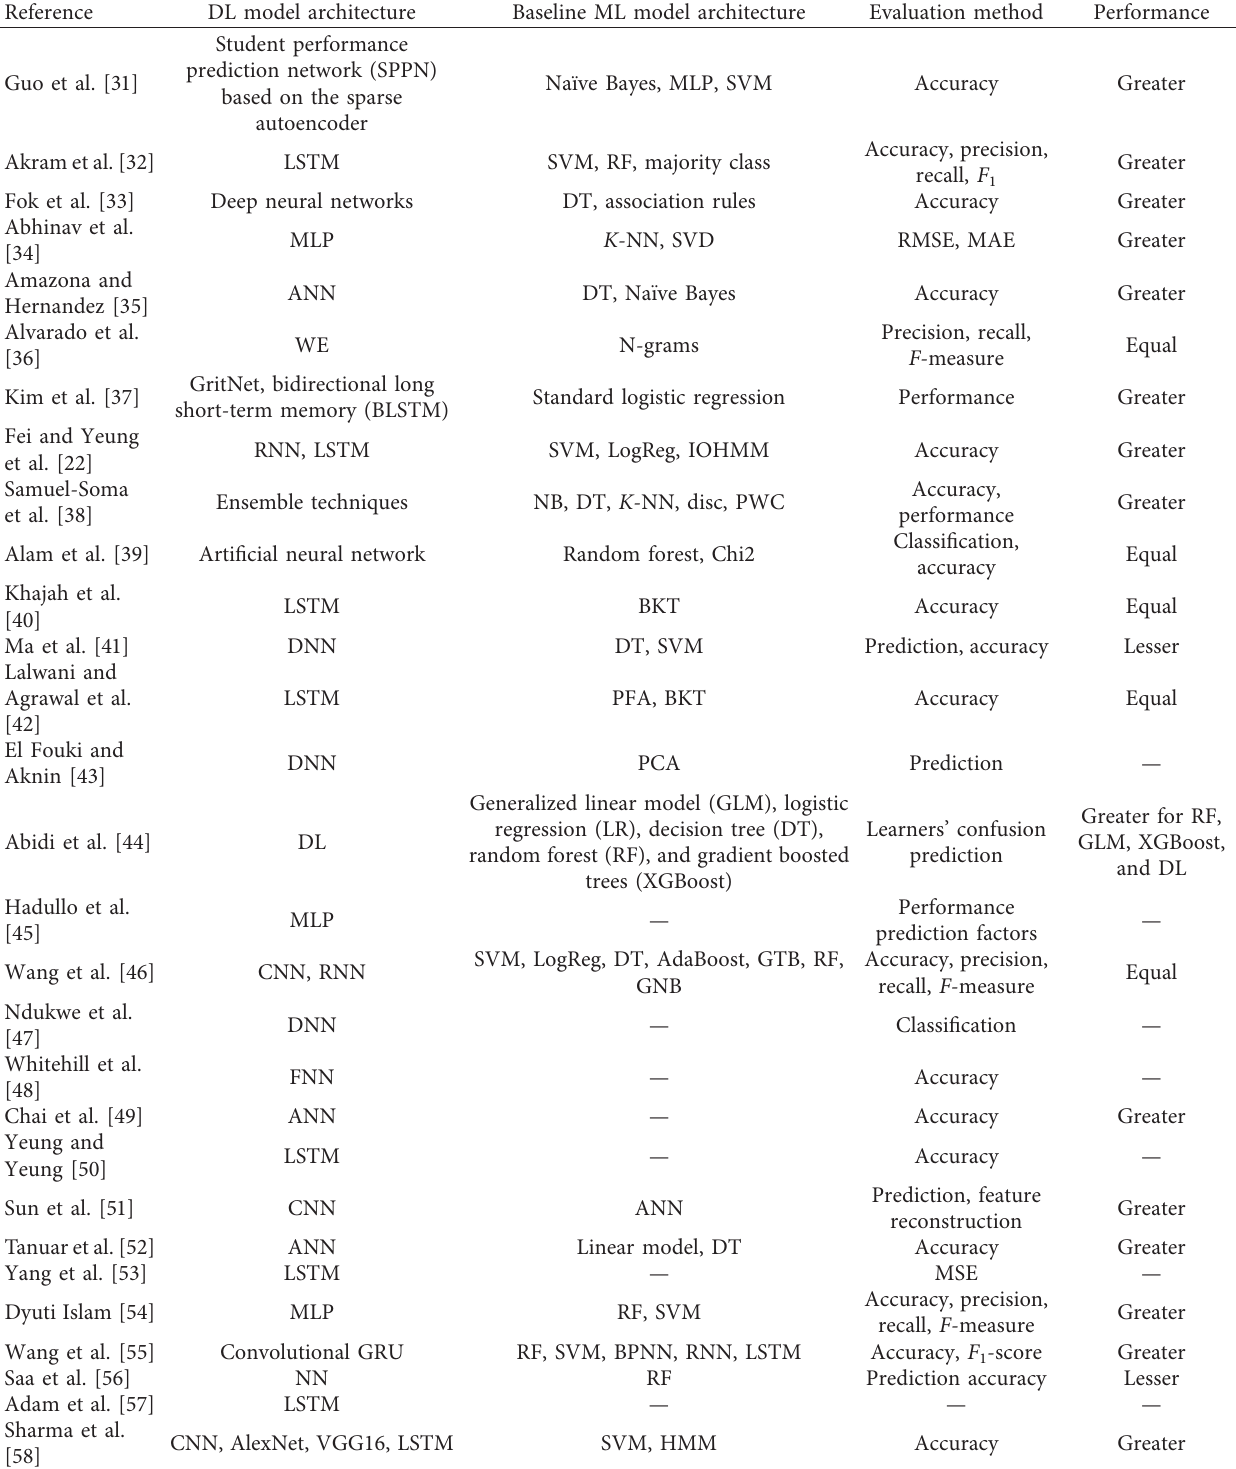
Table 1: DL algorithm/architecture used in education, baseline algorithms, and evaluation method. The column values indicate whether the DL algorithm outperformed baseline algorithms (greater), underperformed (lesser), or obtained the same results